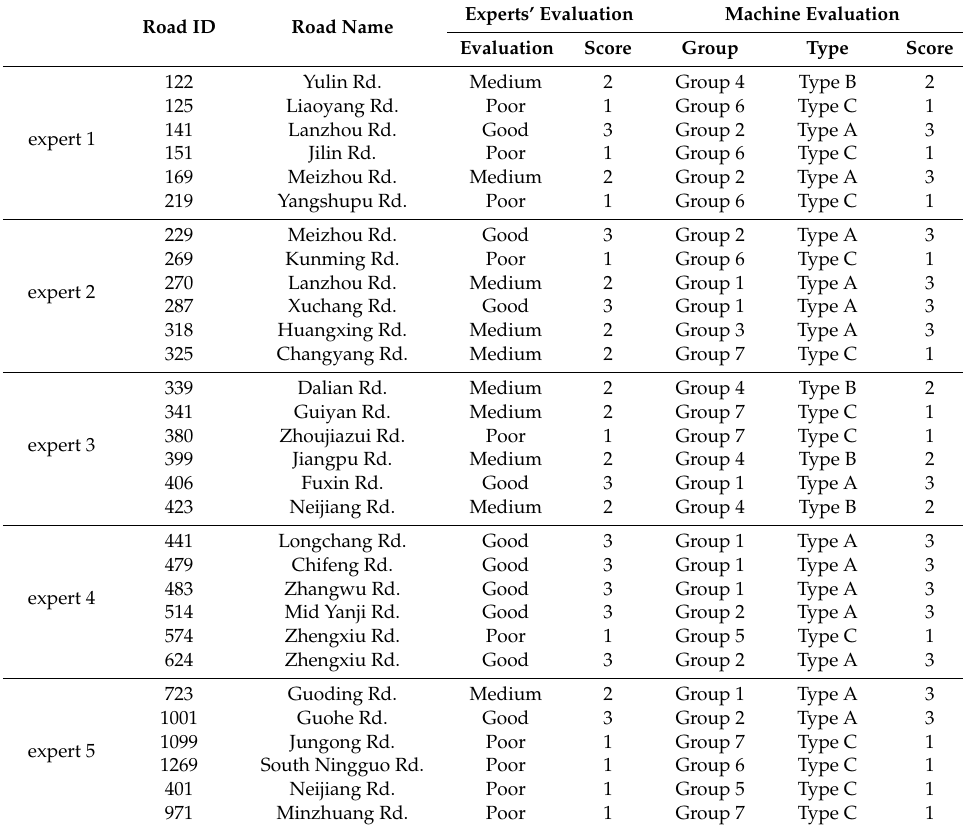
Table A1. Summary table of the evaluations by experts and machine for randomly selected streets. Road